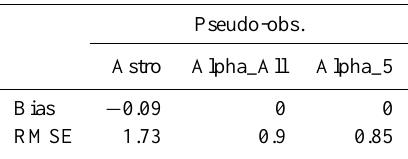
Table 2. Bias and RMSE of pseudo-observation at 1555 observation